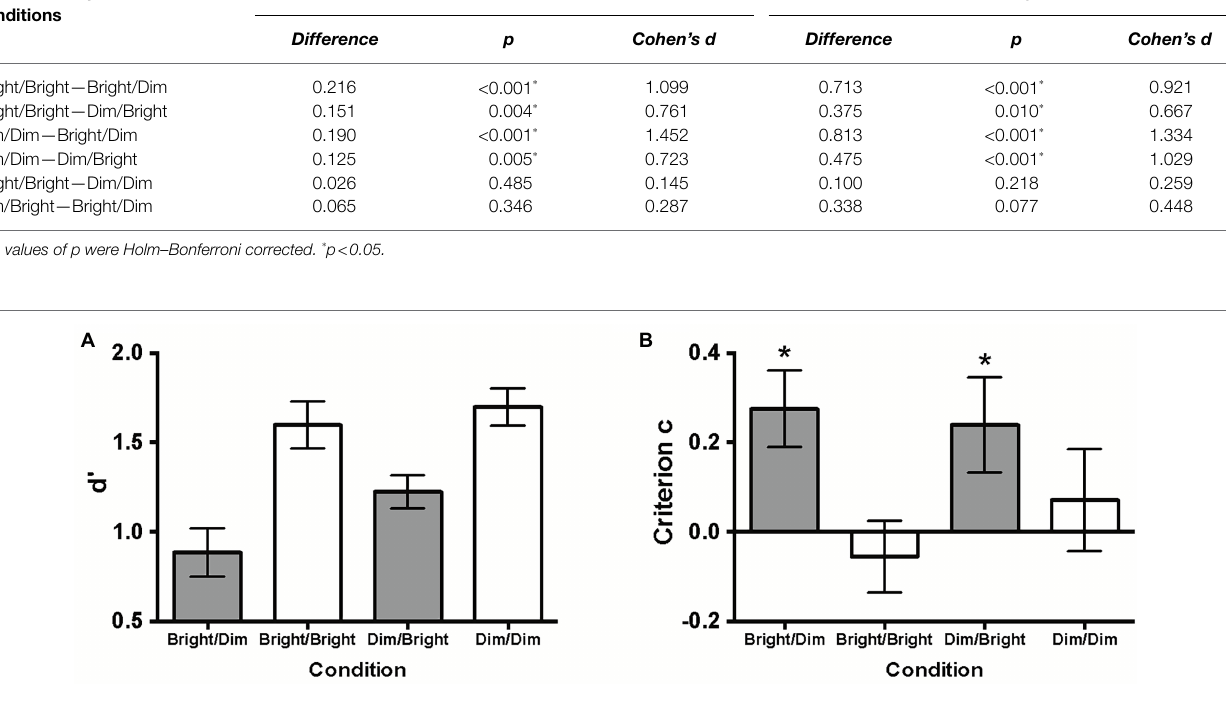
TABLE 2 | Pairwise differences in hit rates and sensitivities d’ between conditions and their effect sizes (Cohen’s d ). Pairwise comparisons between conditions